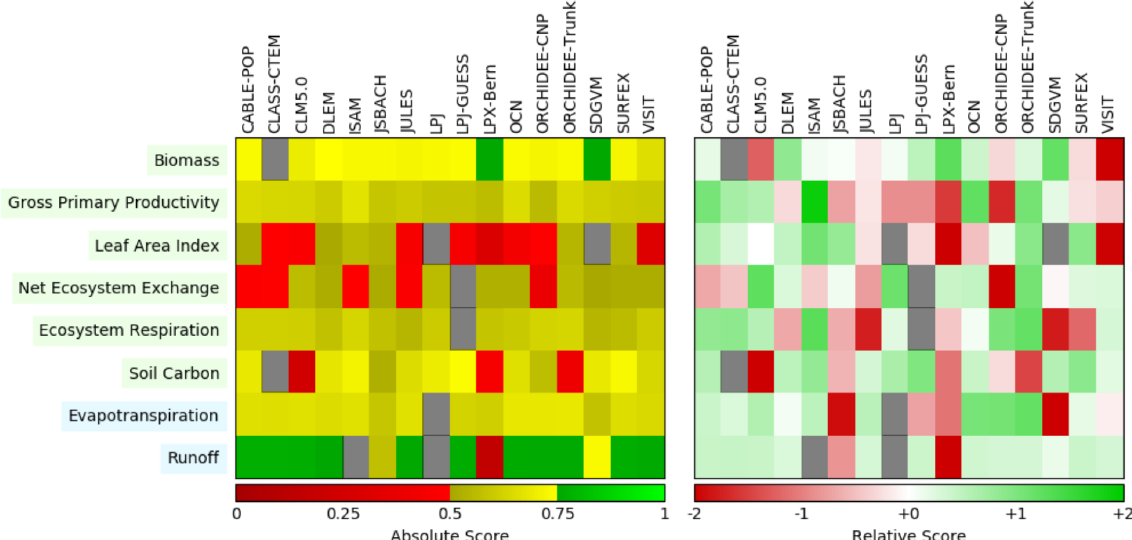
Figure B2. Evaluation of the DGVM using the International Land Model Benchmarking system (ILAMB; Collier et al., 2018) (left) absolute skill scores and (right) skill scores relative to other models. The benchmarking is carried out with observations for vegetation biomass (Saatchi et al., 2011; GlobalCarbon, unpublished data; Avitabile et al., 2016), GPP (Jung et al., 2010; Lasslop et al., 2010), leaf area index (De Kauwe et al., 2011; Myneni et al., 1997), net ecosystem exchange (Jung et al., 2010; Lasslop et al., 2010), ecosystem respiration (Jung et al., 2010; Lasslop et al., 2010), soil carbon (Hugelius et al., 2013; Todd-Brown et al., 2013), evapotranspiration (De Kauwe et al., 2011), and runoff (Dai and Trenberth, 2002). For each model–observation comparison a series of error metrics are calculated, scores are then calculated as an exponential function of each error metric, and finally for each variable the multiple scores from different metrics and observational data sets are combined to give the overall variable scores shown in the left panel. The set of error metrics vary with data set and can include metrics based on the period mean, bias, root-mean-squared error, spatial distribution, interannual variability, and seasonal cycle. The relative skill score shown in the right panel is a Z score, which indicates in units of standard deviation the model scores relative to the multi-model mean score for a given variable. Grey boxes represent missing model